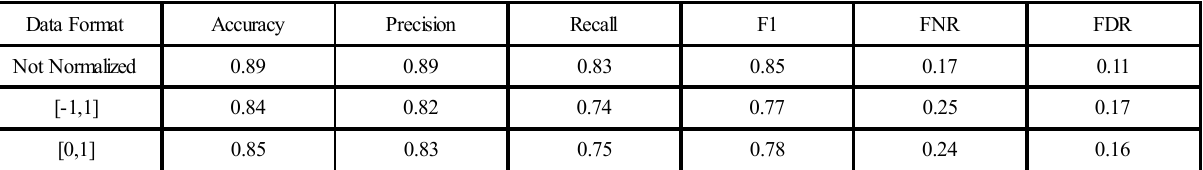
TABLE 4. OPTIMAL CONFIGURATION WITH AND WITHOUT NORMALIZED